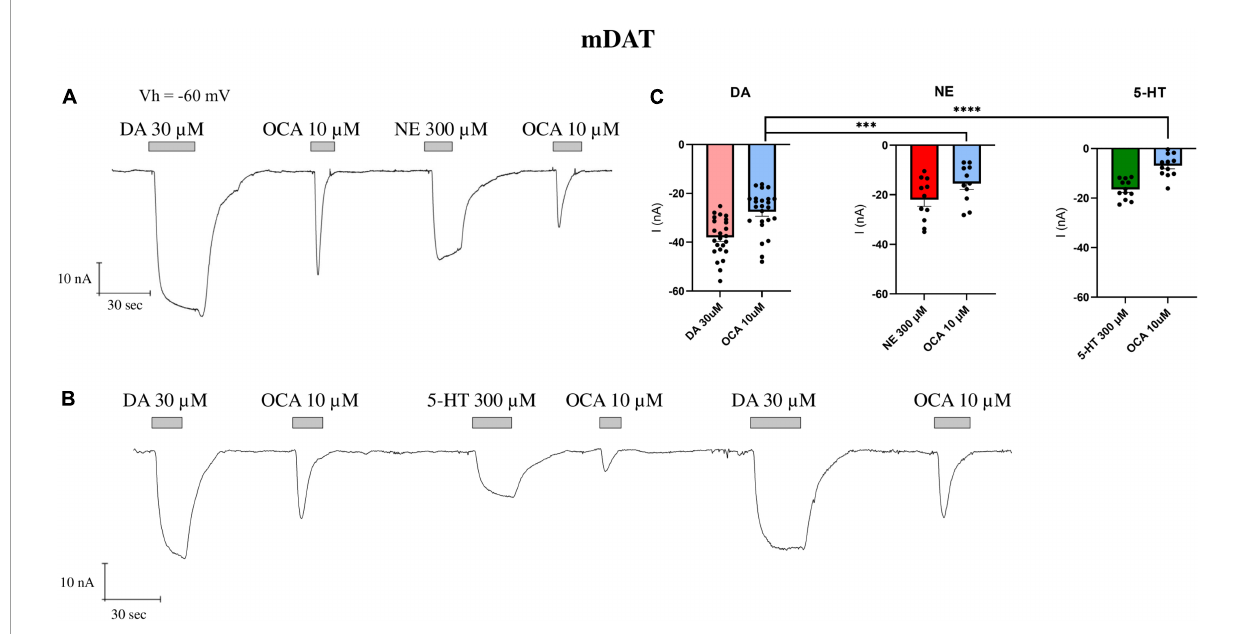
FIGURE3 The partial displacement of OCA by NE and 5-HT. (A) Representative traces of currents recorded by TEVC (Vh = –60 mV) from oocytes expressing mDAT exposed to NE 300 µ M after the first OCA exposure. (B) Representative traces of currents recorded by exposure to 5-HT 300 µ M after the first OCA perfusion. (C) Mean current (nA) ± SE of 11–12/3 n/N; one-way ANOVA F ( 5 , 88 ) = 35.51, ∗∗∗∗ p < 0.0001 followed by Bonferroni’s multiple comparison test; I 0 OCA vs. I’ OCA after NE: ∗∗∗ p = 0.001; I 0 OCA vs. I’ OCA after 5-HT: ∗∗∗∗ p < 0.0001.